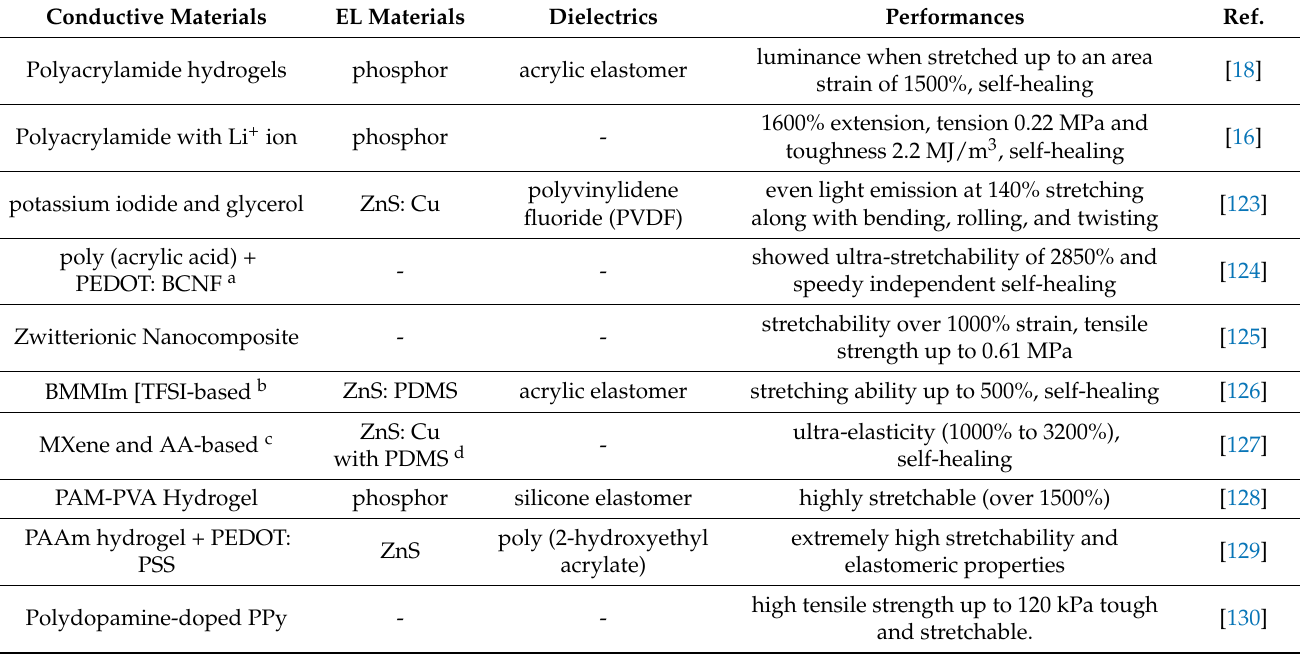
Table 1. Comparison of conductivity-based hydrogel materials for electroluminescence